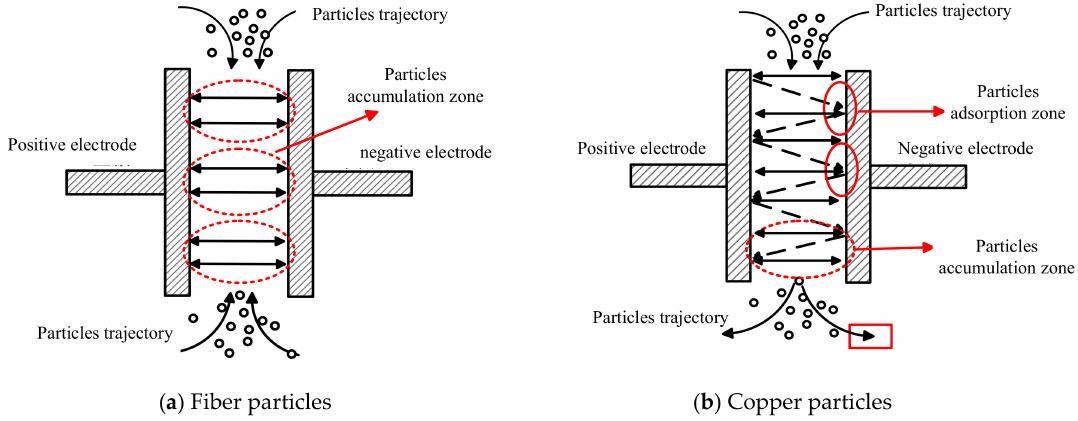
Figure 4. Motion trajectory diagram of particles in insulating oil under DC uniform electrical